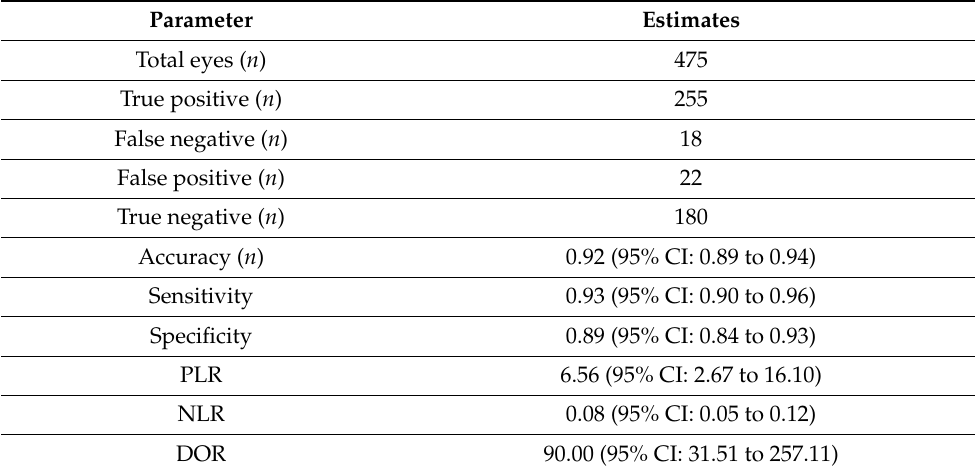
Table 2. Statistical summary of the diagnostic precision parameters in the